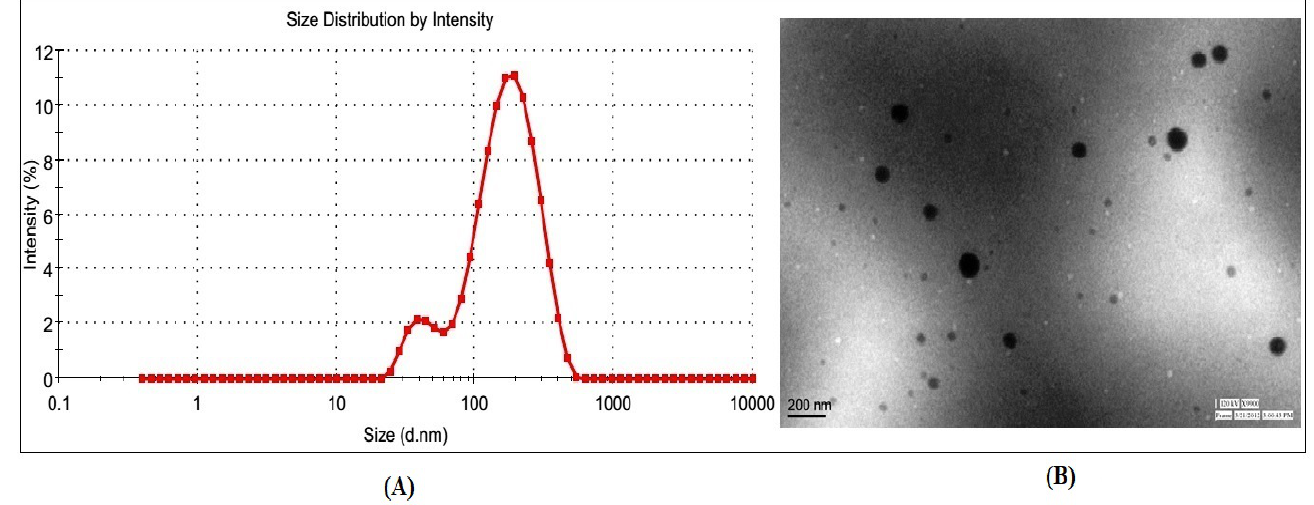
Figure 2. Showing ( A ) Vesicle size graph and ( B )TEM image of CIP-BLO-opt